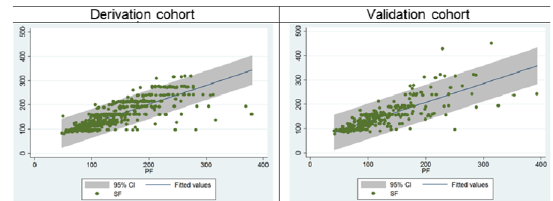
Fig. 1 (abstract 000583). Scatterplot of S/F and P/F ratios in the derivation and validation chort.